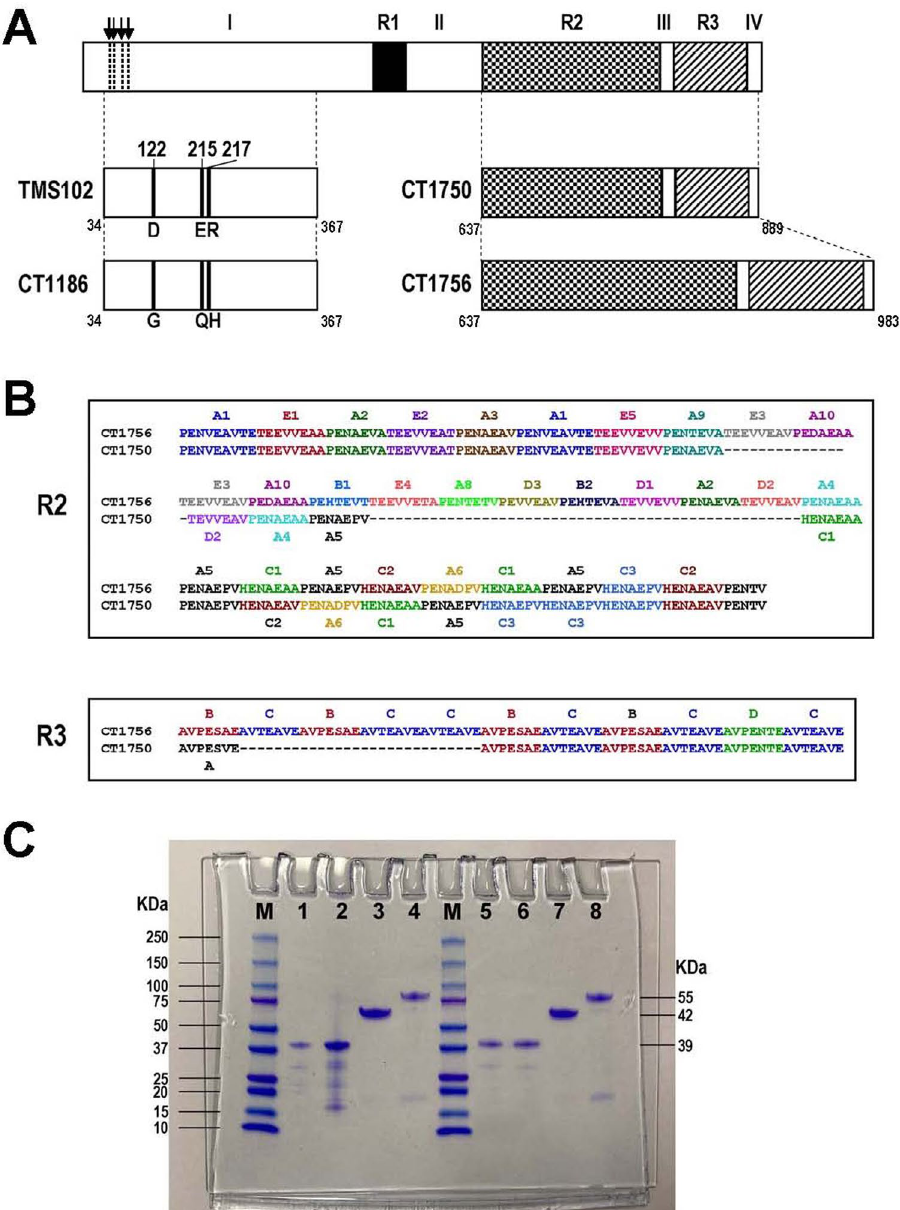
Figure 1. ( A ) Structure of PvMSP9 depicting conserved domains (I–III) and repeat domains (R1–R3). Approximate locations, amino acid substitutions and length of repeat domains in the recombinant proteins are shown correspondingly underneath. Four conserved cysteines at residues 49, 52, 64 and 71 are marked with downward arrows and broken vertical lines in the upper diagram. Positions of the first and the last amino acid residues for each recombinant protein are shown underneath at both ends of the schemes ( B ) Amino acid sequences of repeat domains R2 and R3 in recombinant proteins CT1750 and CT1756. The nomenclatures for the repeat units are listed above and below the sequences with corresponding colors. ( C ) Coomassie brilliant blue-stained SDS gel of purified PvMSP9 recombinant proteins. Lane M represents molecular weight marker. Lanes 1–4 are proteins TMS102, CT1186, CT1750 and CT1756, respectively, under reducing condition (with β-mercaptoethanol). Lanes 5–8 are the corresponding proteins under non-reducing condition (without